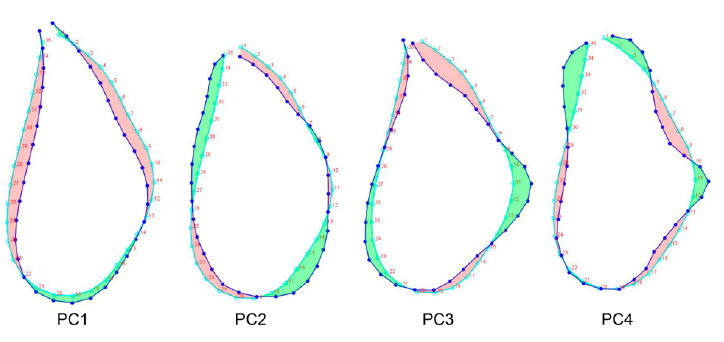
Figure 4. Principal components of the cross-sections of the symphysis region. Light blue line: Procrustes fit, Blue line: PCs. Red area: atrophy; Green area: protrusion. PC1 or elongated drop shape is described as a suprabasal atrophy and a wider base.